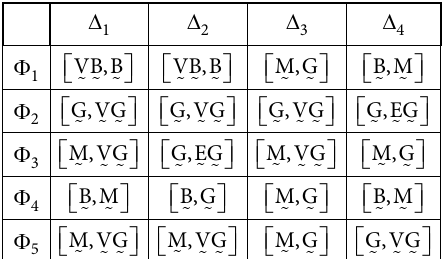
Table 10. The standardized ULT matrix